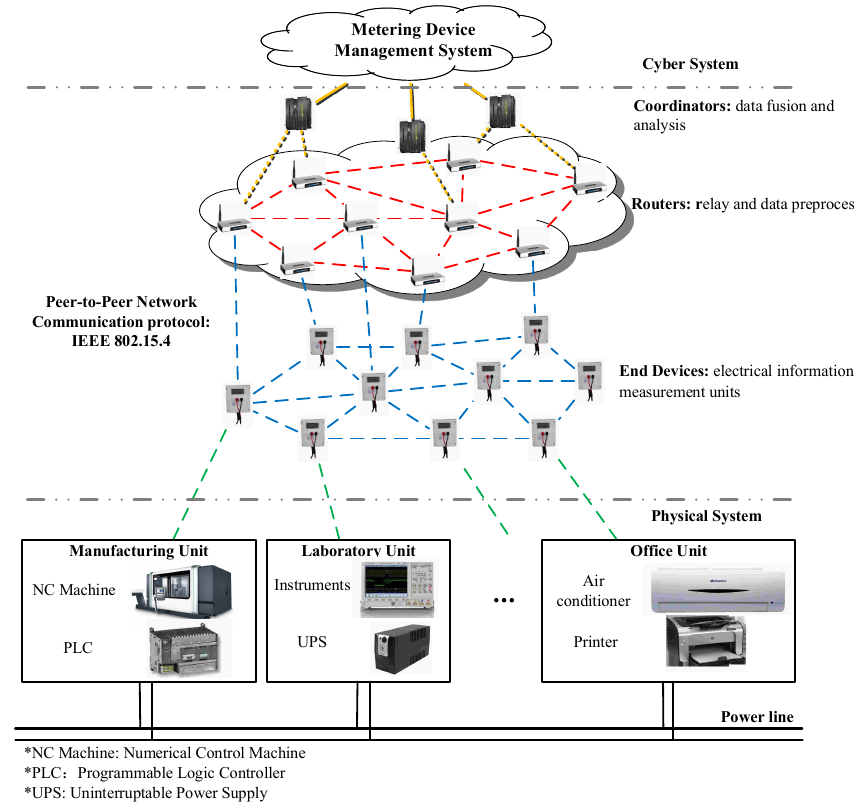
Figure 4. The distributed electrical information monitoring network structure of the cyber-physical energy system testbed in the residential power consumption